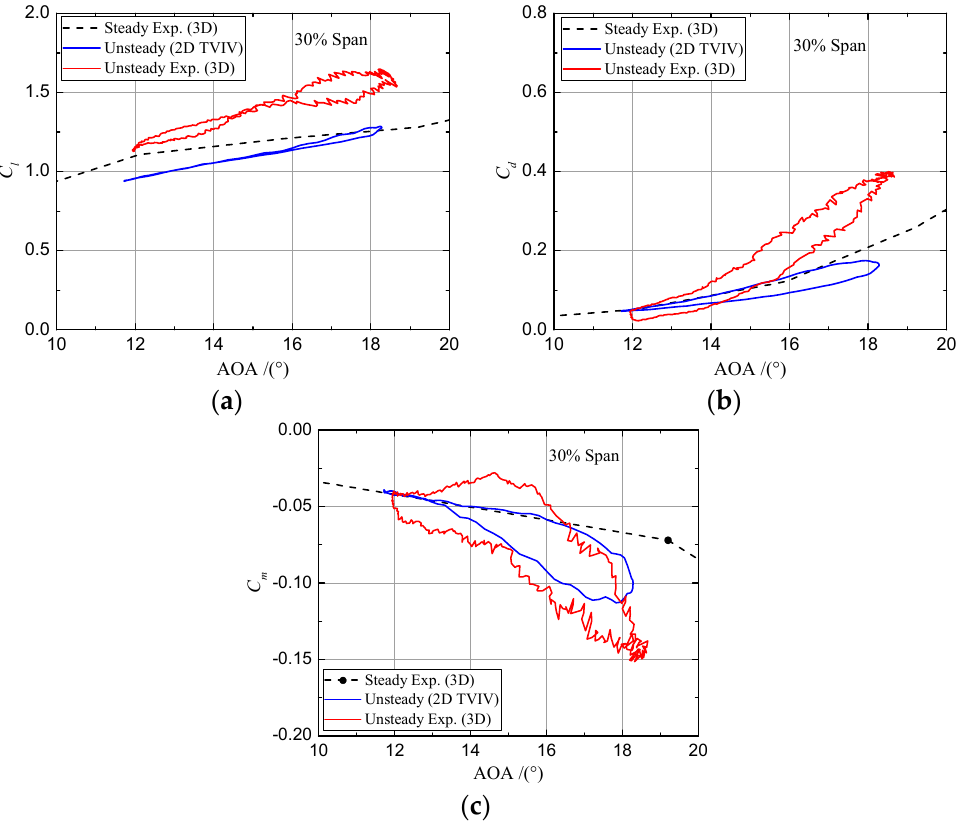
Figure 17. Hysteresis loops of the lift, drag and pitching moment coefficients at 30% spanwise location. The wind speed is 10 m/s, and the yaw angle is 10°. Steady Exp. (i.e. experimental) (3D) denotes the experimental data under axial inflow, while Unsteady Exp. (3D) denotes the experimental data under yawed inflow. ( a ) The lift coefficient; ( b ) The drag coefficient; ( c ) The pitching moment coefficient.